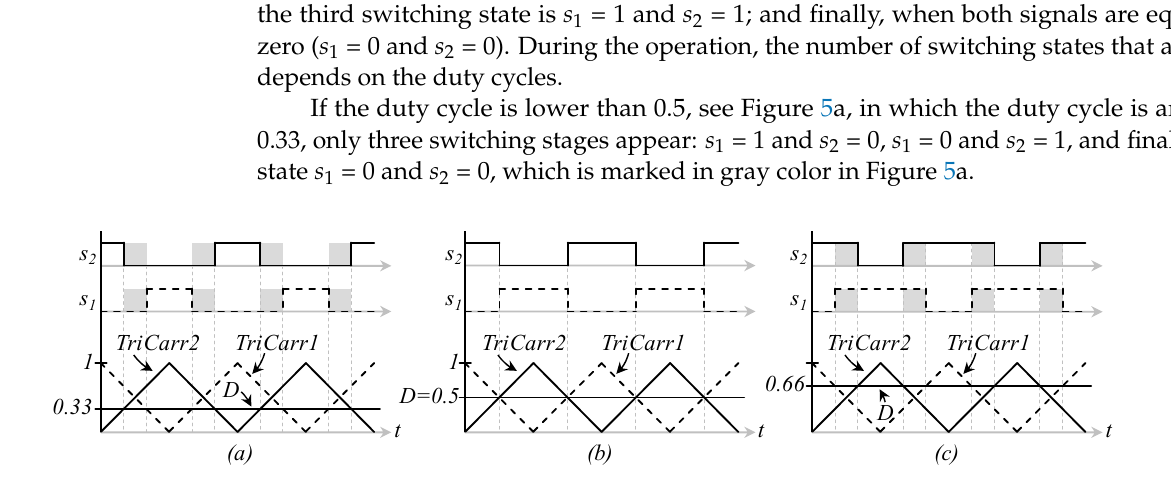
Figure 5. PWM scheme under several values of D , ( a ) D = 0.33, ( b ) D = 0.5, and ( c ) D = 0.66.